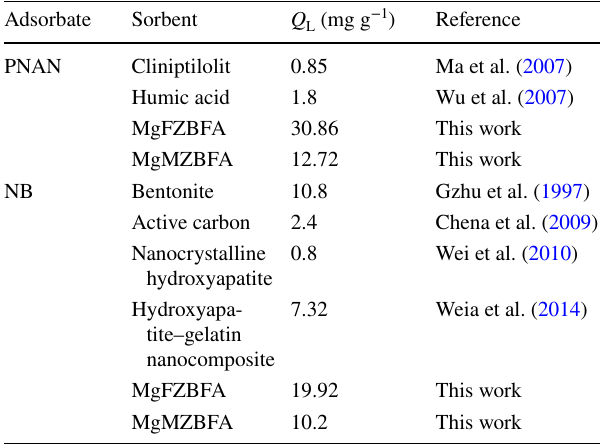
Table 6 Comparison of the maximum adsorption capacities of sorb- ents for PNAN and